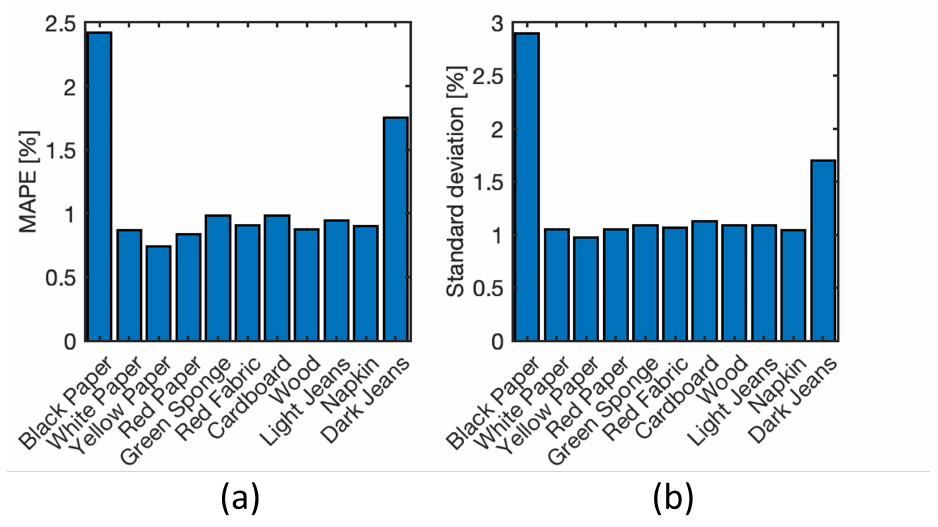
Figure 16. MAPE ( a ) and standard deviation ( b ) of each substrate averaged within the entire spectral range.